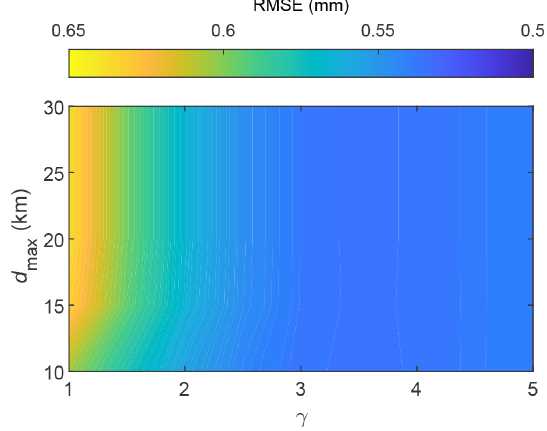
Figure 5. IDW calibration based on RGs: the RMSE between ob- served and simulated rainfall depths, for different values of γ and d max , from Eq.